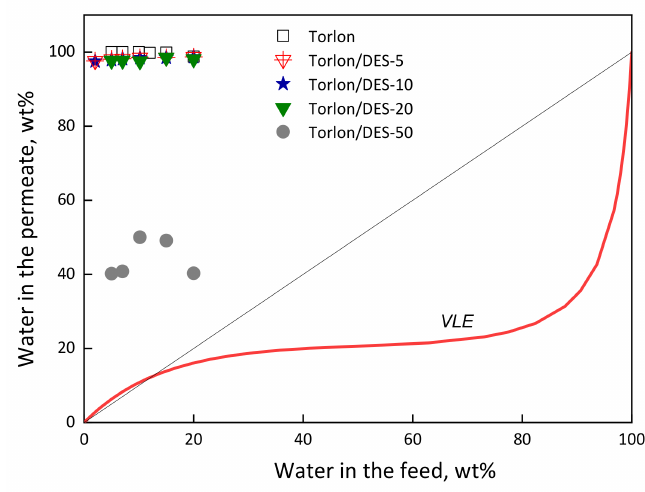
Figure 7. Dependence of water concentration in the permeate on water concentration in the feed for pervaporation using Torlon-based membranes; the vapor–liquid equilibrium (VLE) curve for water–IPA mixture, 50 ◦ C.